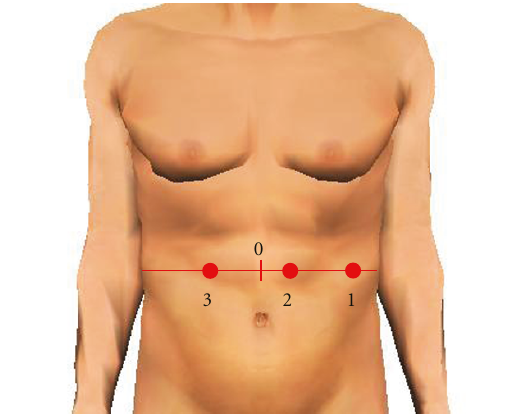
Figure 6: Tangential z -polarization scenarios. 1, 2, 3 designate the antenna allocations and 0 is the trunk center